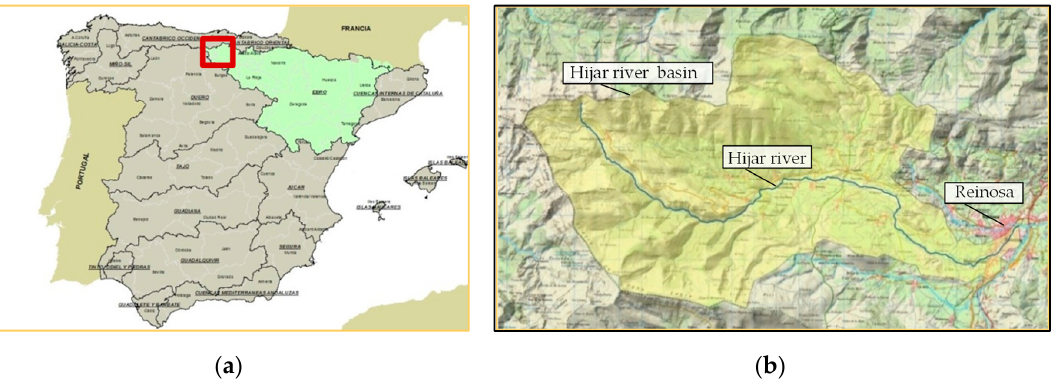
Figure 2. Hijar river basin. ( a ) Overall Site map. ( b ) Detailed Site map.